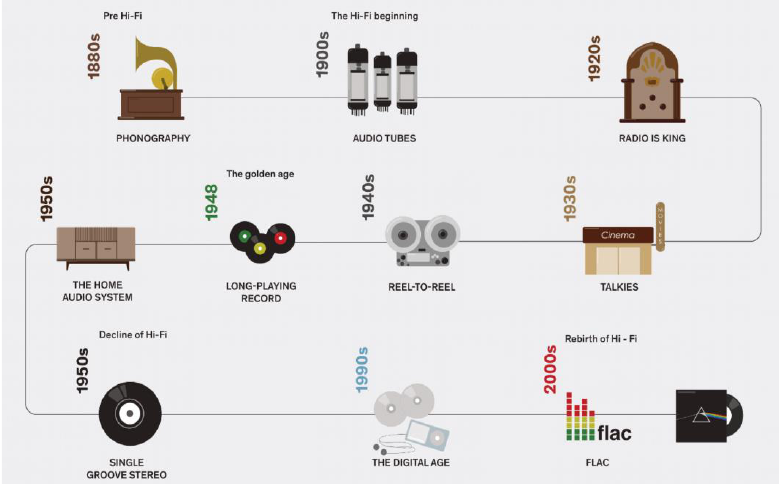
Figure 2. Infographic about the evolution of Hi-Fi systems, from phonography to digital music.